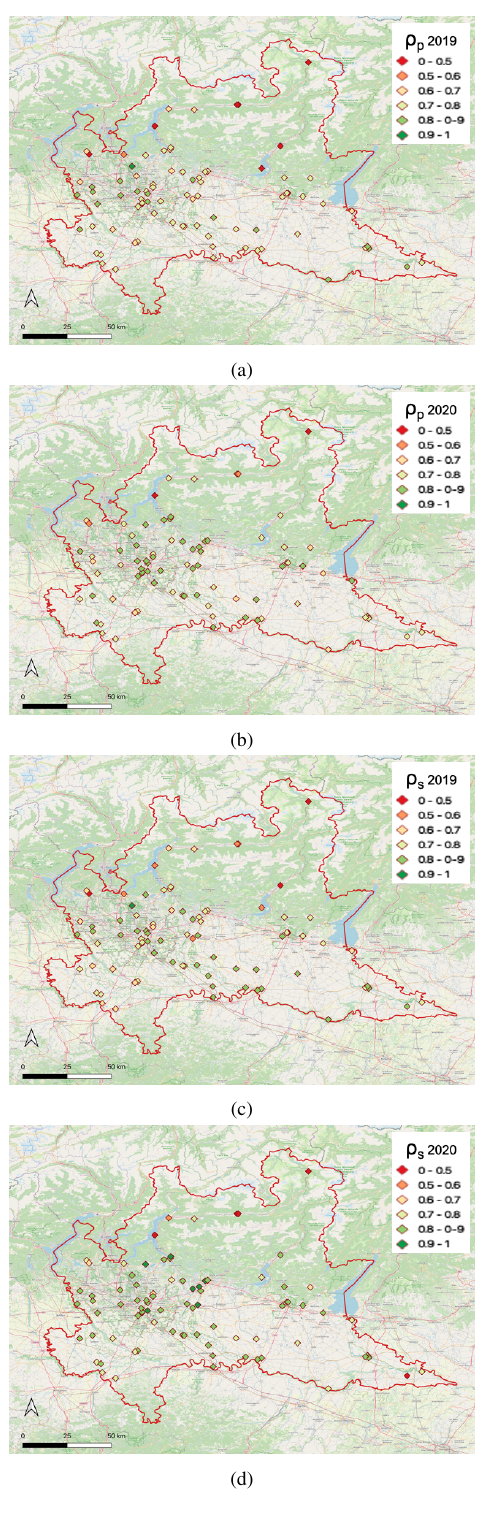
Figure 3. Maps of Pearson’s correlation coefficients ( ρ p ) at each sensor location, computed from the comparison of NO 2 concentration time-series of ARPA Lombardia sensors and the Sentinel-5P in the two analysis periods, 2019 (a) and 2020